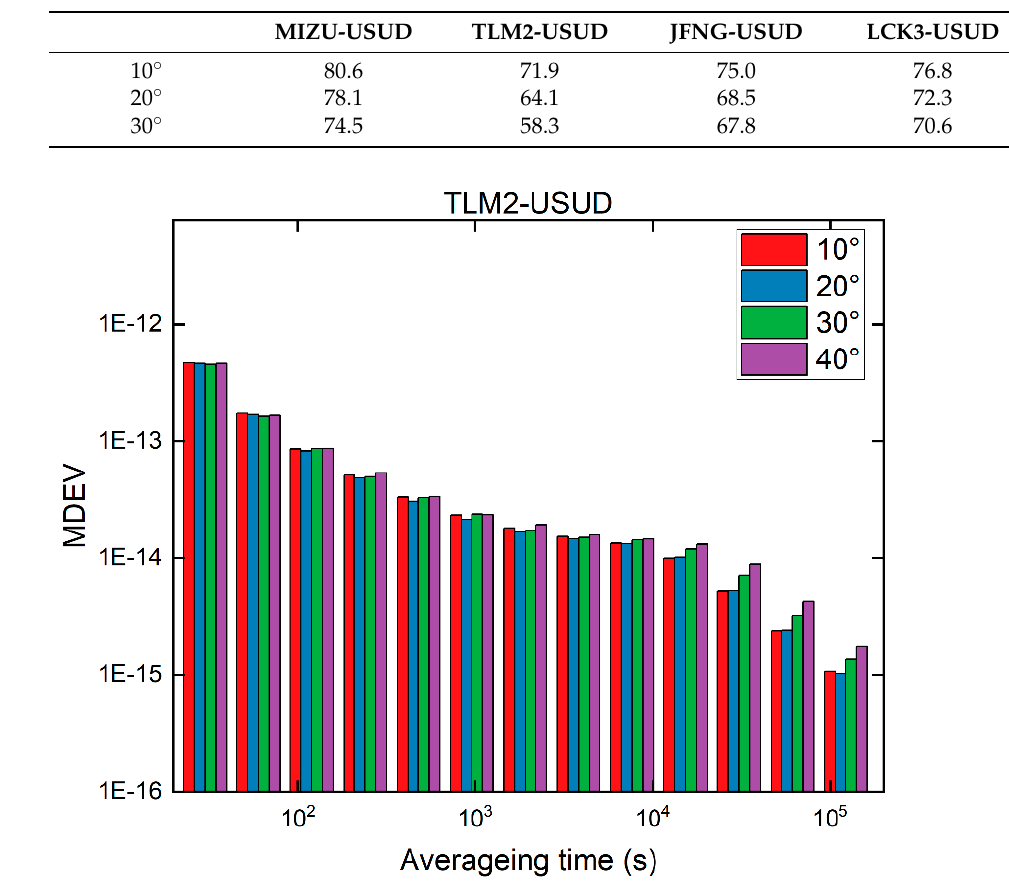
Figure 19. The TCH results for TLM2-USUD time